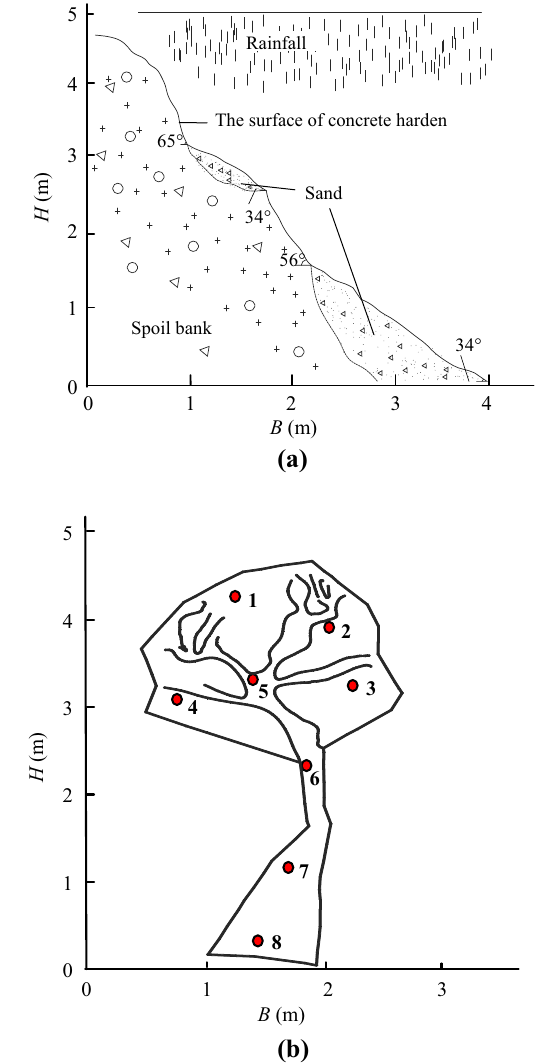
Fig. 3 Schematic diagrams of the model ( a ) and locations of rainfall collection ( b